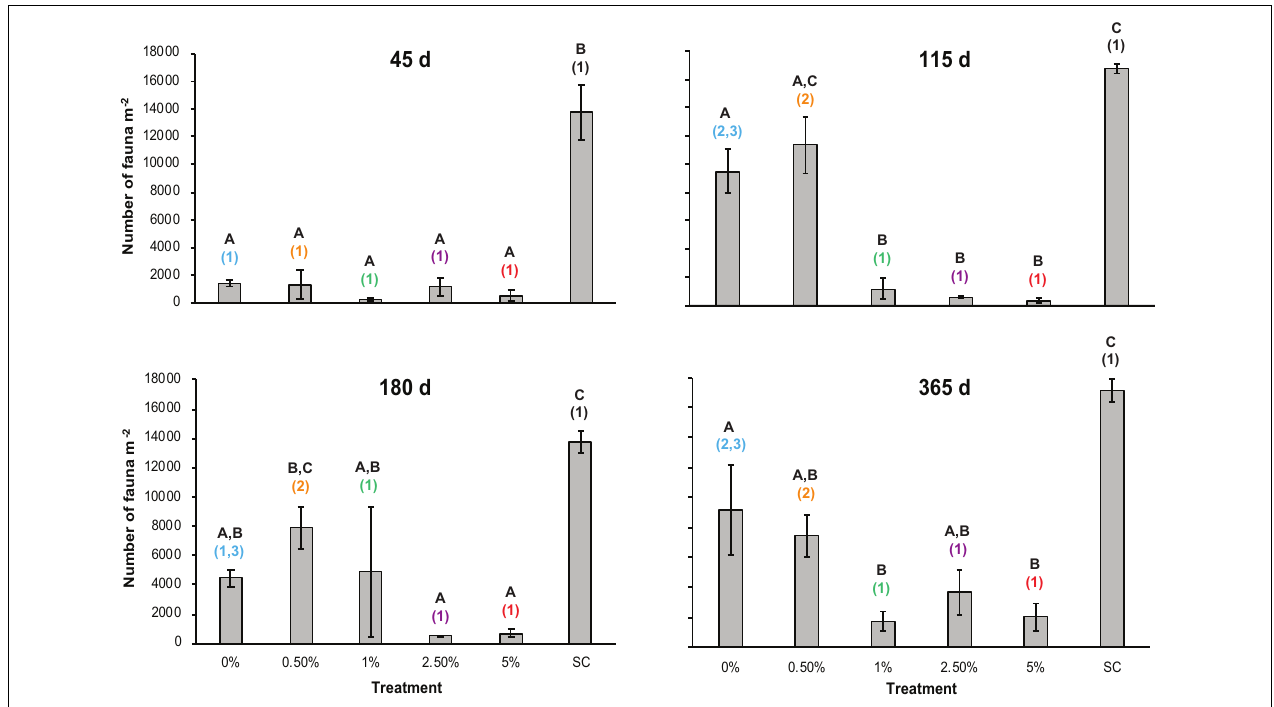
FIGURE 5 | Mean macrofaunal abundance (per m 2 ) in the different treatments over time. Errors bars denote ± 1 standard error of the mean ( n = 3). Different letters denote significant differences ( p < 0.05) between the means of the treatments at each sampling point. Different colored numbers denote significant differences ( p < 0.05) between the means of a specific treatment at different sampling times. Colors used for the different treatments are the same as used in Figure 2 to aid clarity.